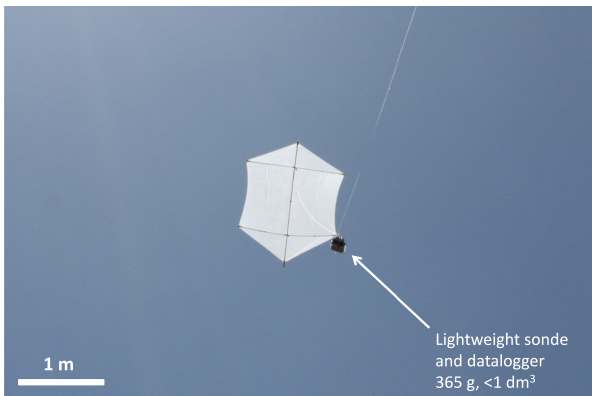
Table 1. Characteristics of the WVMR in situ sounding